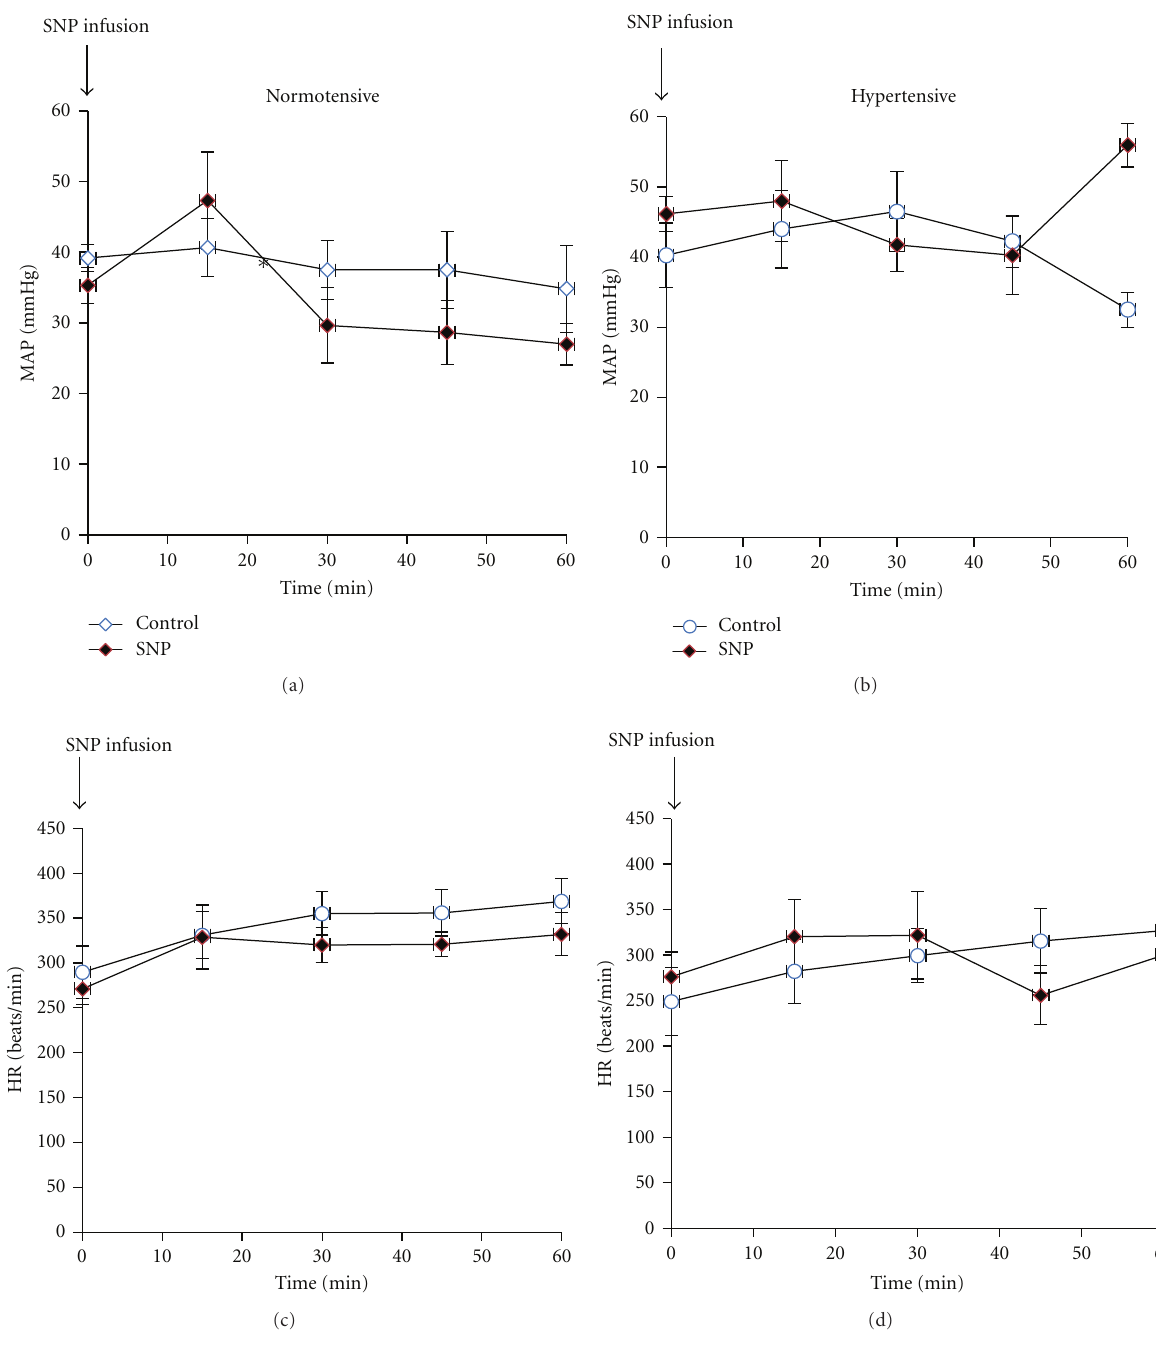
Figure 2: E ff ect of SNP administration on MAP and HR after 2 h hemorrhagic shock period in normotensive and hypertensive rats. ∗ P < 0 . 05 compared to nontreated group.